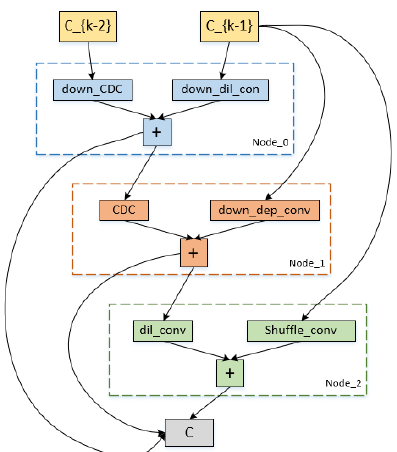
Figure 6. Medical Landmark detection on the ISBI2015 dataset under a different method. From left to right are the results of Baseline-2, Baseline-3, and our method. Red points are predicted landmarks; green points are ground truth.